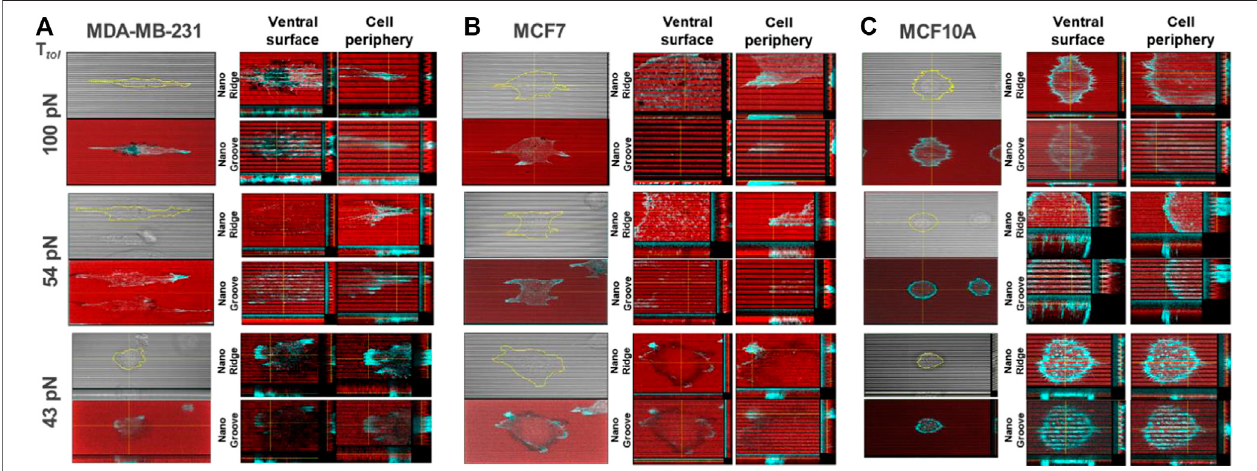
FIGURE 3 | Reconstructed layer-by-layer force map of the three cell lines on the nanosurface. Each cell exerted different levels of integrin tensions on the nanoridges and the nanogrooves. The magnitude of spatial integrin tension on the nanosurface was analyzed with actin polymerization. The red color indicates the fl uorescent signal from the immobilized-TGT, and the cyan color indicates F-actin. (A) MDA-MB-231 cells applied integrin tension higher than 100 pN to the nanoridges and nanogrooves at the ventral cell surface and the nanoridges at the cell tip. (B) MCF7 cells exerted integrin tensions in a range of 43 – 54 pN along the cell periphery. (C) MCF10A cells generated integrin tensions in a range of 54 – 100 pN along the cell periphery.